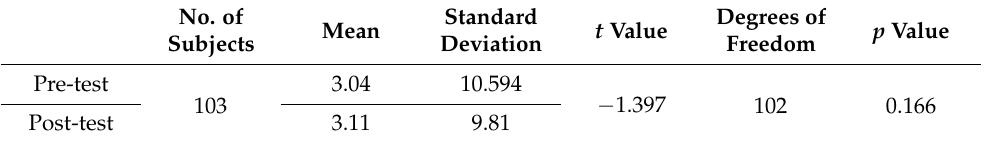
Table 5. Results of Independent Sample t -test on the Students’ Cognition of and Interest in Science. No. of Standard Mean Subjects